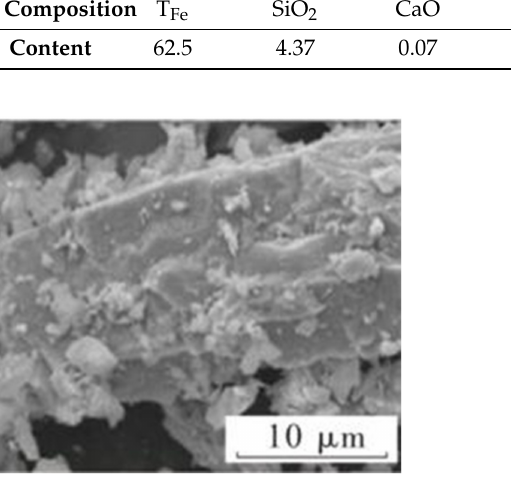
Figure 1. SEM of Newman ore before reduction. Table 2. Chemical composition of cow dung (wt